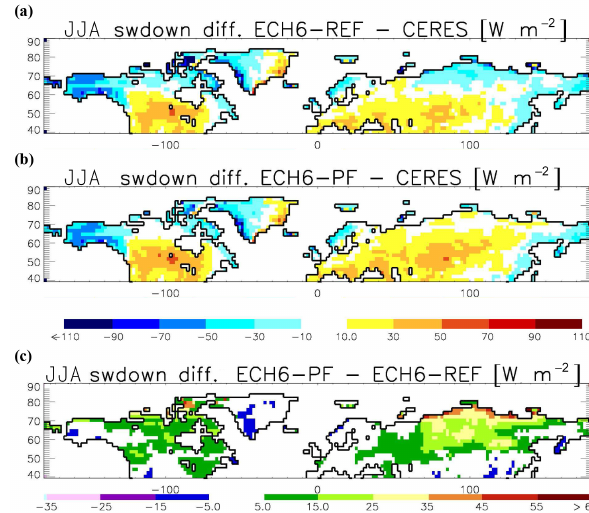
Figure 3. Boreal summer (JJA) surface solar incoming radiation differences (Wm 2 ) to CERES data for (a) ECH6-REF, (b) ECH6- PF, and (c) difference between ECH6-PF and ECH6-REF.